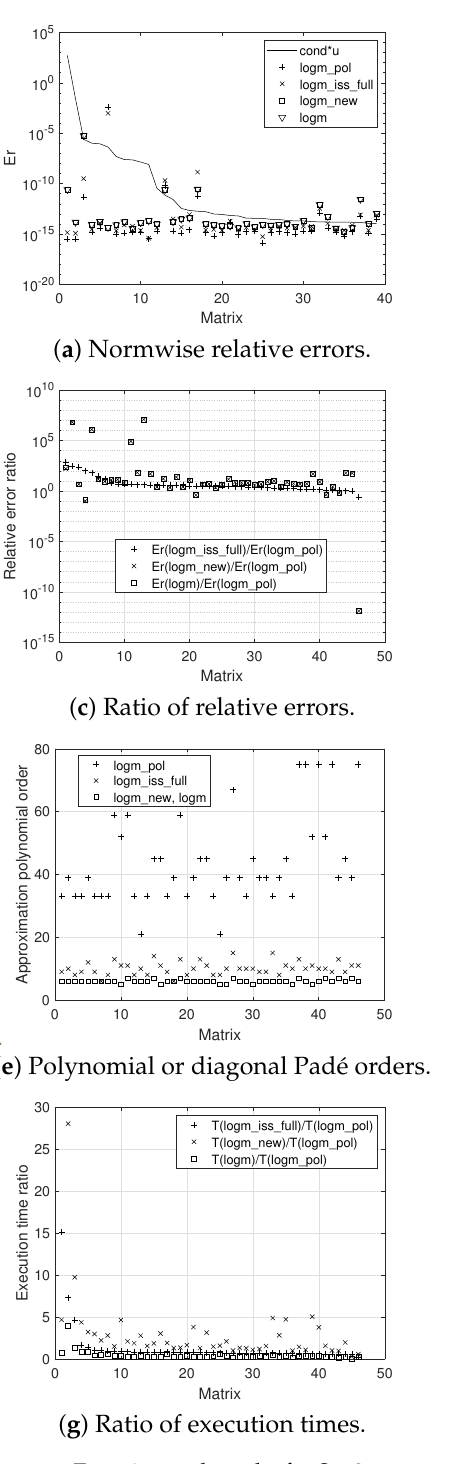
Figure 3. Experimental results for Set